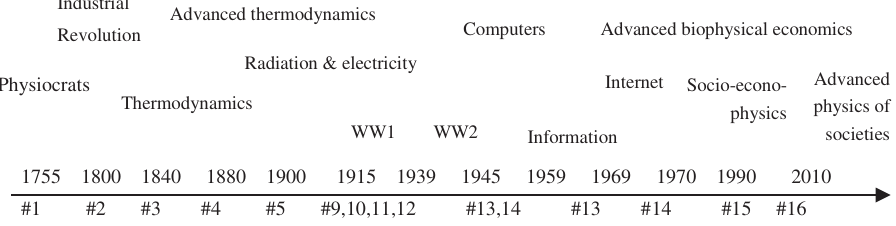
Fig. 1. Illustration of biophysical economics' advances, with the developments in science and technology, where the lower panel of numbers refer to the conceptual highlights and the respective scholars that are presented in the Table